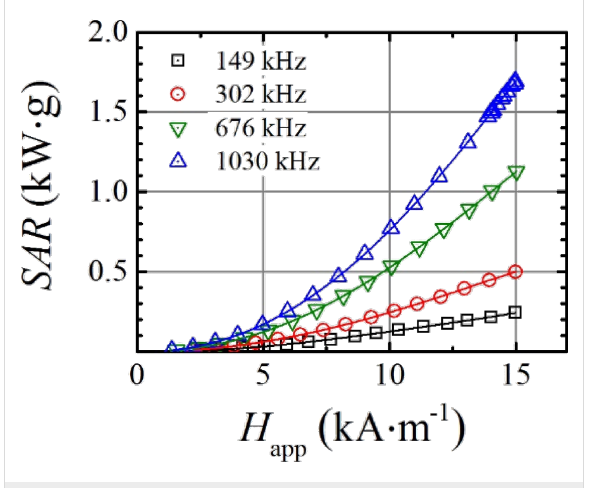
Figure 4: SAR values versus applied magnetic field intensity ( H app ) at different field frequencies for the Fe 3 O 4 @PMAO_RGD water dispersed